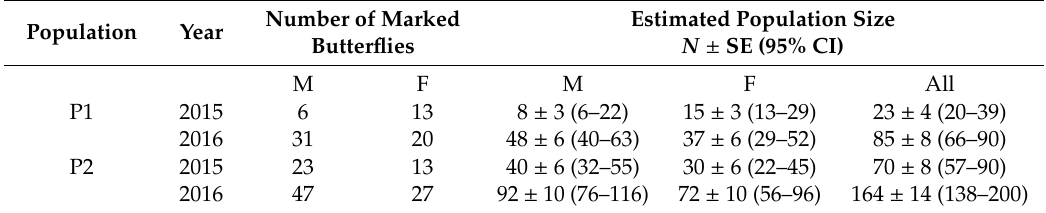
Table 2. Sample sizes and estimated population sizes for the two populations (P1 and P2) of Scolitantides orion in Poland in two seasons.